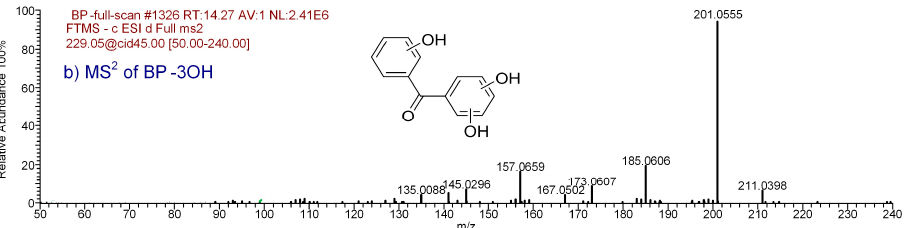
Figure A3. MS 2 spectra of BP-3OH by HRMS.